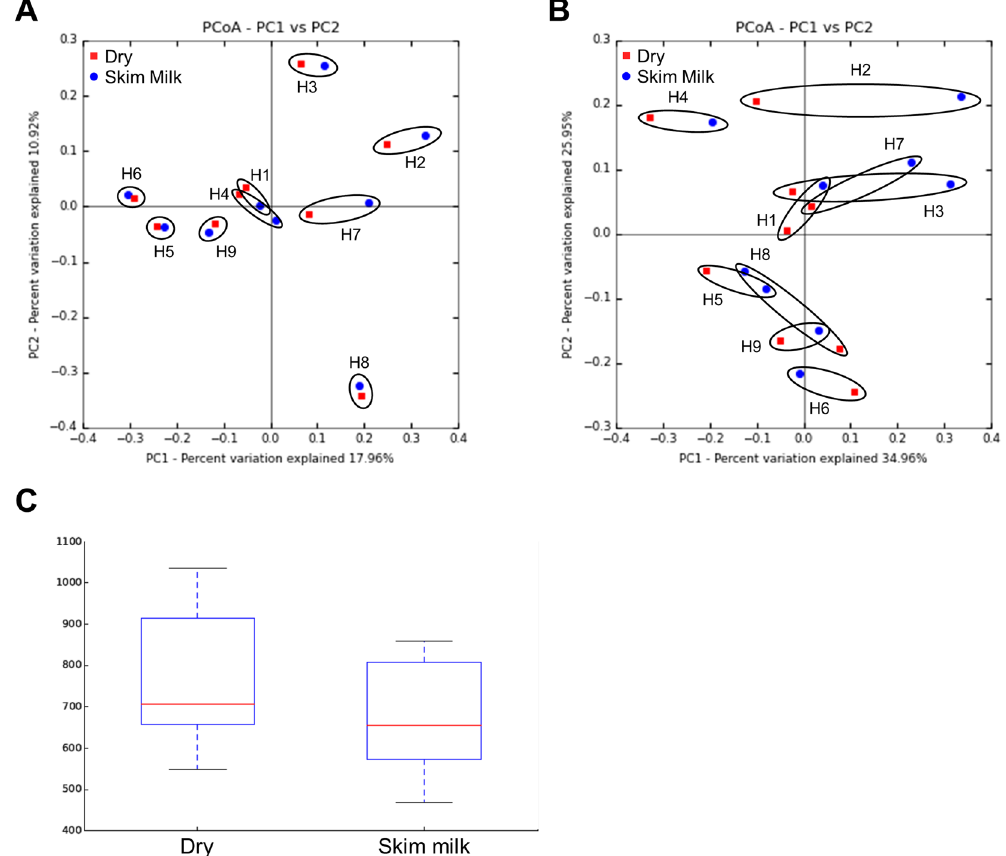
Figure 2. Preservation of the composition and structure of the intestinal microbiota following resuspension and freezing. PCoA plot showing the ( A ) unweighted UniFrac distance (p < 0.001) and ( B ) weighted UniFrac distance (p < 0.001). Red squares indicate freeze-dried feces samples and blue circles indicate frozen feces resuspended in BHI + skim milk media. Each encircled area corresponds to samples from the same human donor (H1 to H9). ( C ) Box plots showing microbiota diversity based on the OTUs observed (counts of unique